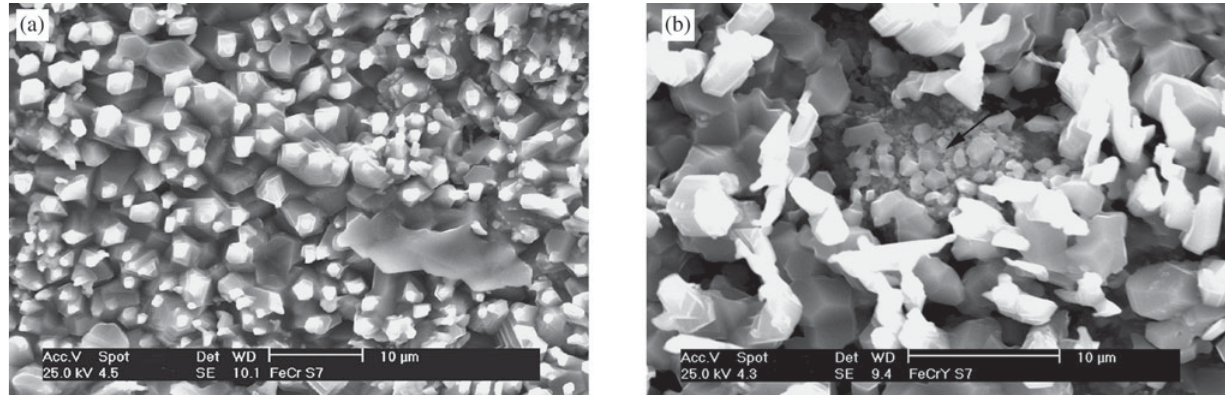
Figure 2. Scaled oxide still sticking to the alloy surface after sulphidation at 800 °C. a) FeCr; b) FeCrY.